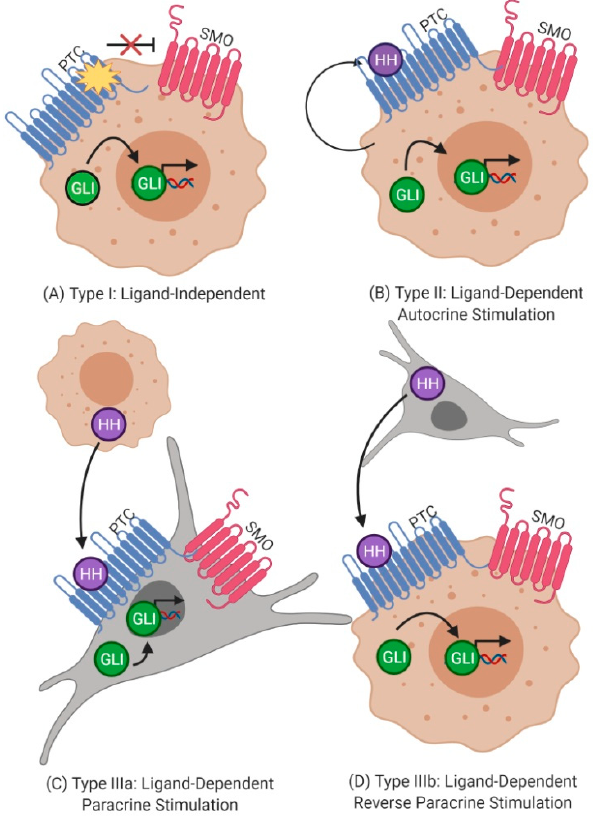
Figure 2. Models of signaling in Hedgehog pathway activation in cancer. ( A ) Type I: Ligand-Independent. ( B ) Type II: Ligand-Dependent Autocrine Stimulation. ( C ) Type III: Ligand-Dependent Paracrine Stimulation. ( D ) Type III: Ligand-Dependent Reverse Paracrine Stimulation.